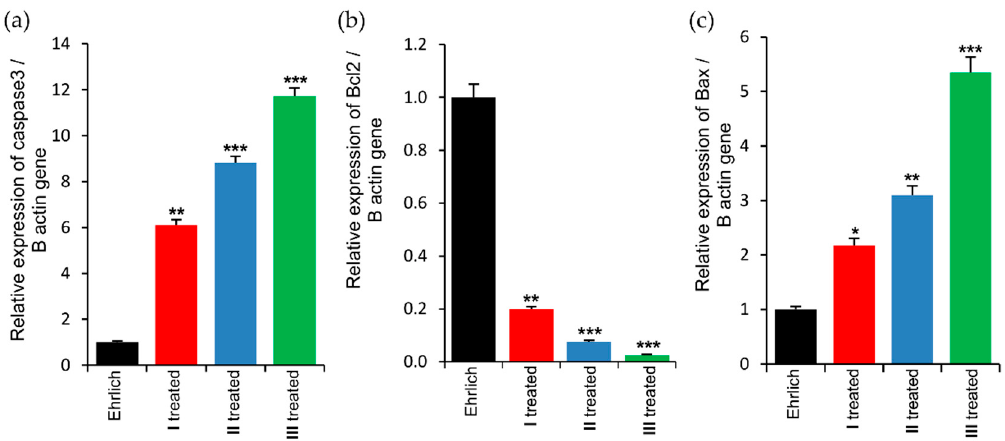
Figure 9. Real-time quantitative PCR analysis of the ( a ) caspase 3, ( b ) Bcl2 , and ( c ) Bax gene expression in liver tissue of Ehrlich mice. Analyses were performed in triplicate. Values (columns and error bars) are expressed as mean ± SEM. *, **, and *** indicated significant difference at p < 0.05, p < 0.001, and p < 0.0001, respectively.